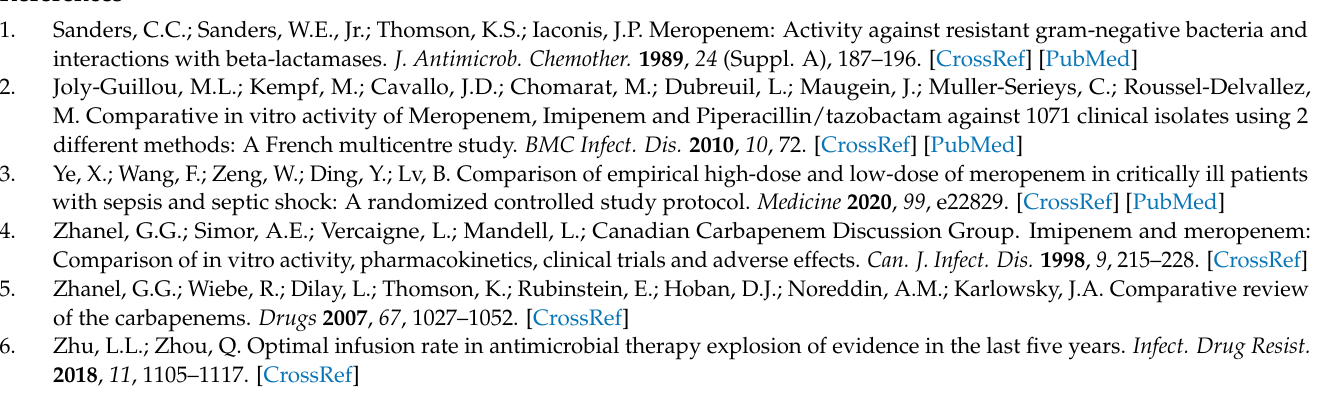
Figure S7: The RMSE of the models under different number of concentrations, Text S1: Literature search